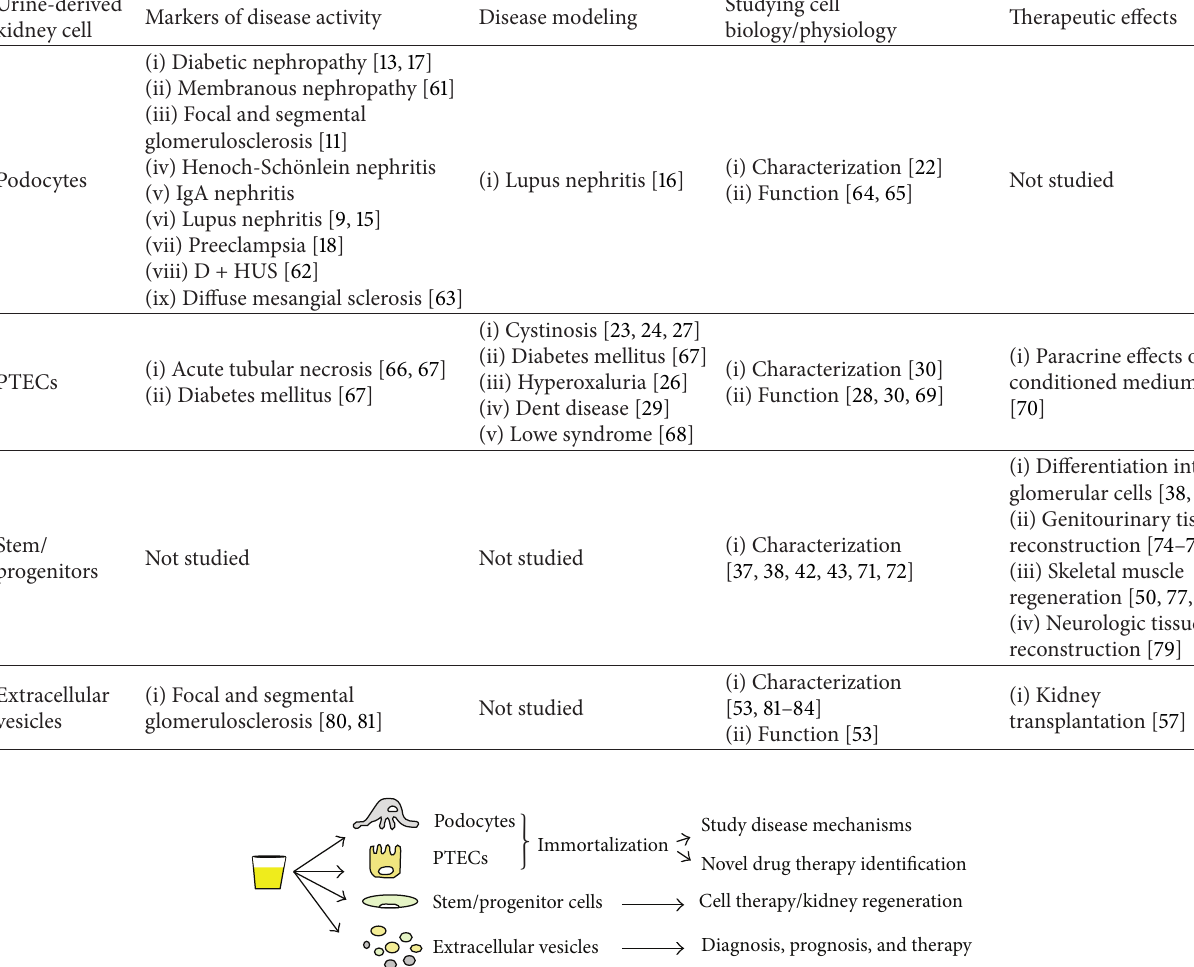
Table 1: Types of kidney cells exfoliated in urine and their current applications.